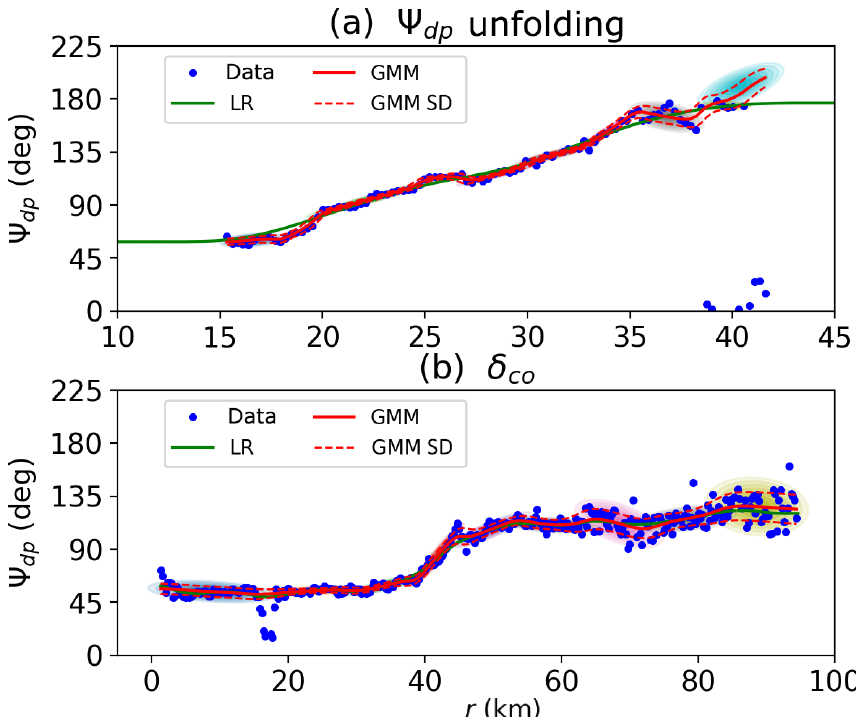
Figure 4. Examples of (cid:57) dp density estimation: (a) a (cid:57) dp unfolding case and (b) a δ co case. The blue points are the (cid:57) dp data, the green curve represents the (cid:57) dp profile obtained by the linear regression model (LR), and the red curve indicates the (cid:57) dp profile produced by the Gaussian mixture method (GMM). The dashed lines are the standard deviations, while the colored ellipses show the components of the Gaussian mixture. The x axis is the radar range in